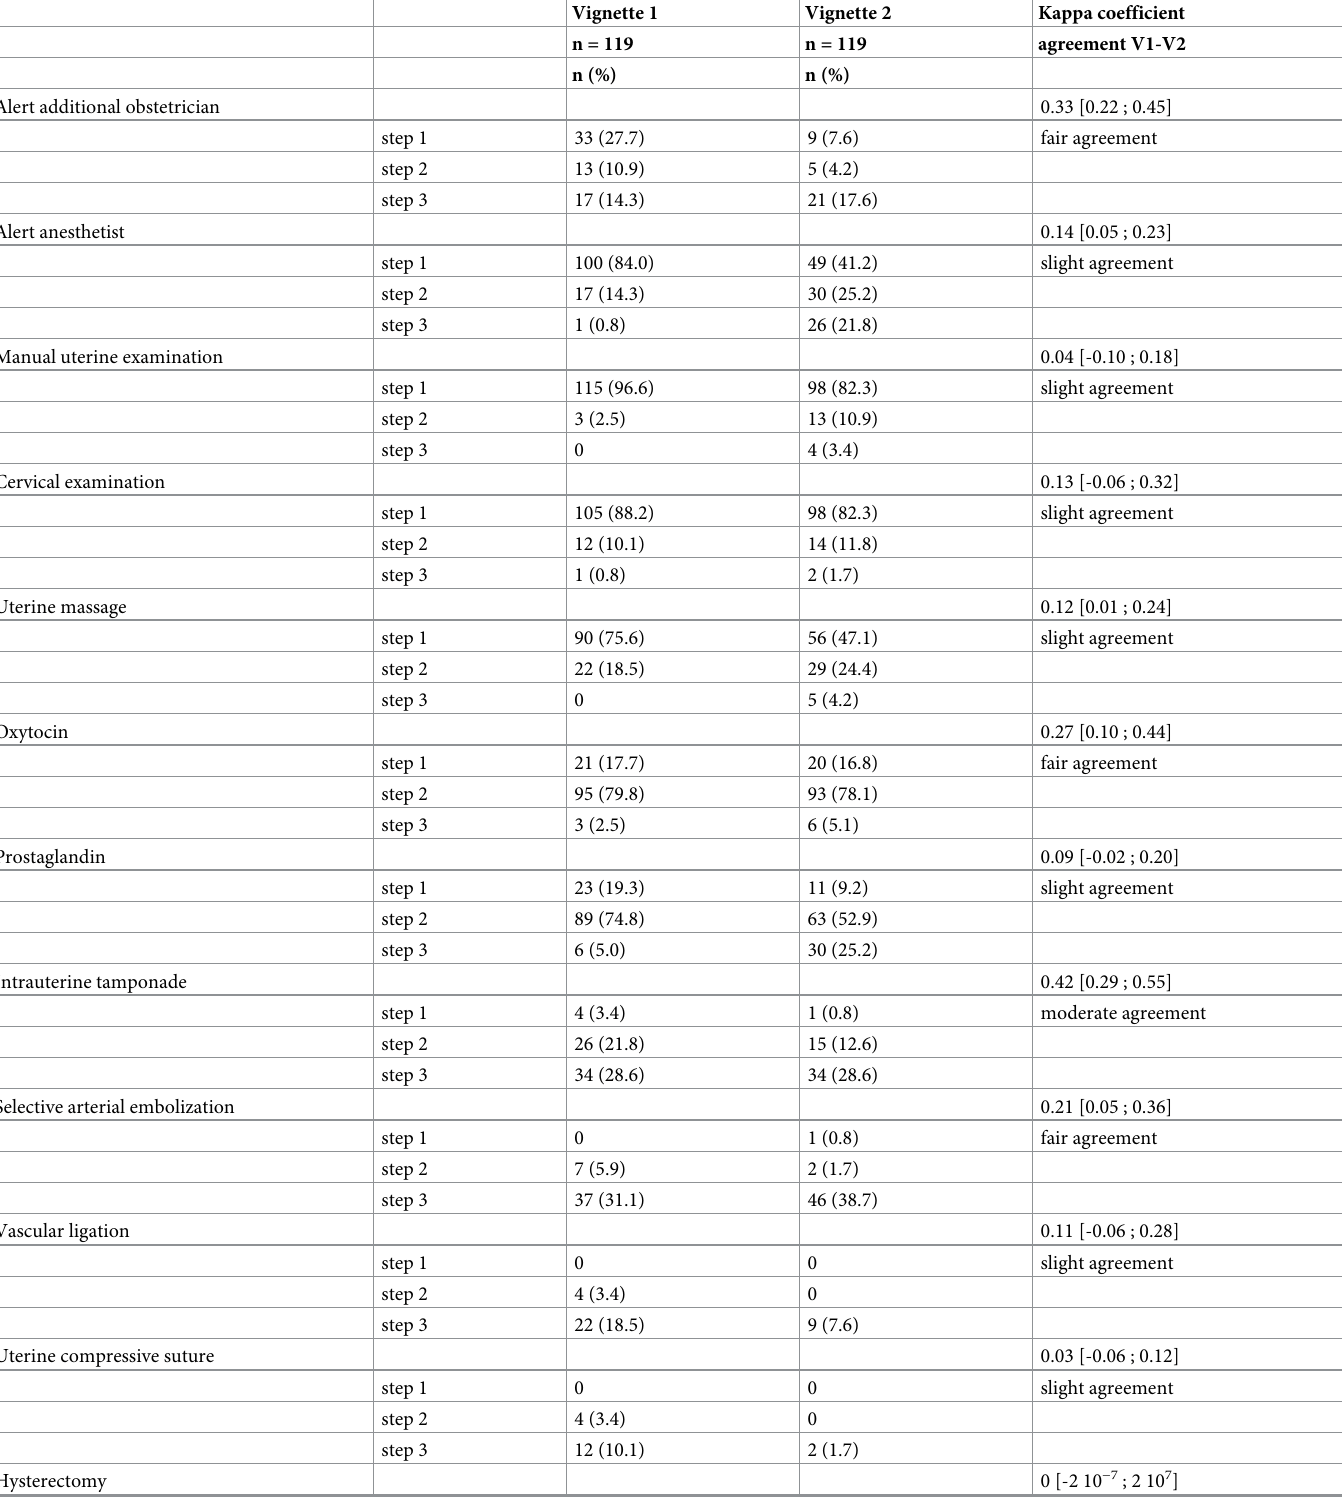
Table 2. Agreement about management actions and their timing between vignette 1 and vignette